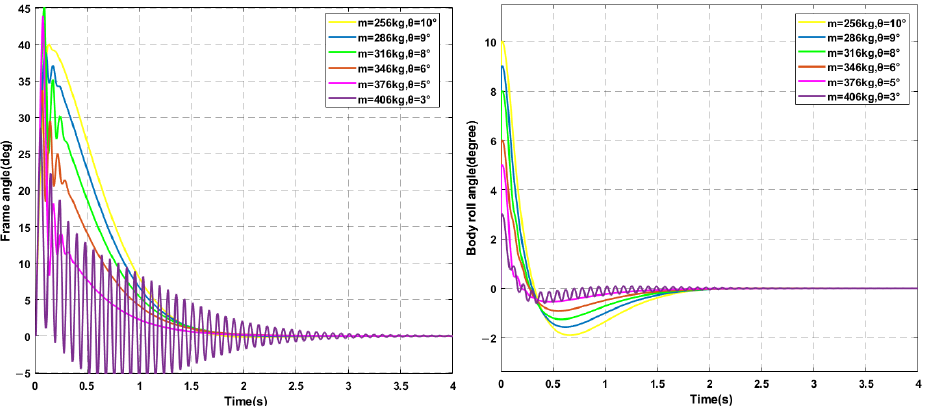
Figure 12. Simulation results: Robustness analysis of the vehicle body at rest.